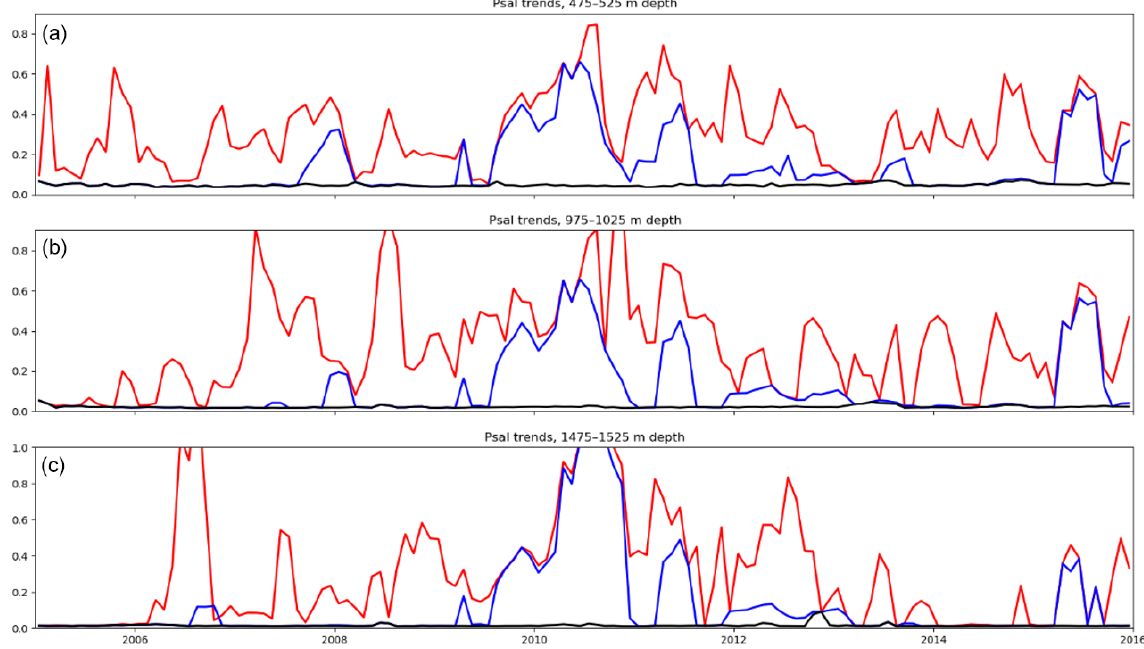
Figure 8. Mean salinity standard deviation in the 475–525m depth layer (a) , 975–1025m depth layer (b) , and 1475–1525m depth layer (c) . The raw dataset (red), NRT dataset (blue), and CORA dataset (black) are represented.